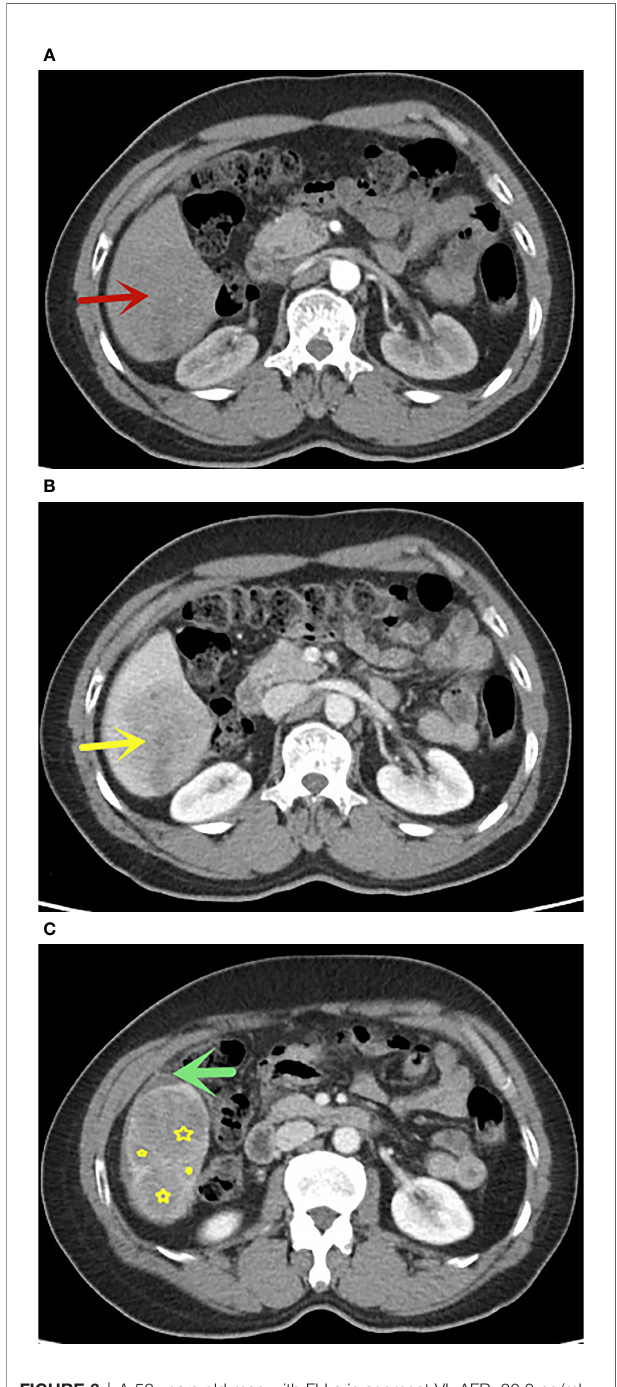
FIGURE 6 | A 58 years old man with FLLs in segment VI, AFP>20.0 ng/ml, (A) no APHE in arterial phase (red arrow), (B) washout in portal venous phase, (C) presence of nodule-in-nodule architecture(yellow star) and ascites (green arrow), without satellite lesions. This lesion indicates malignancy according to the nomogram score greater than 80 points. The pathological result was hepatocellular